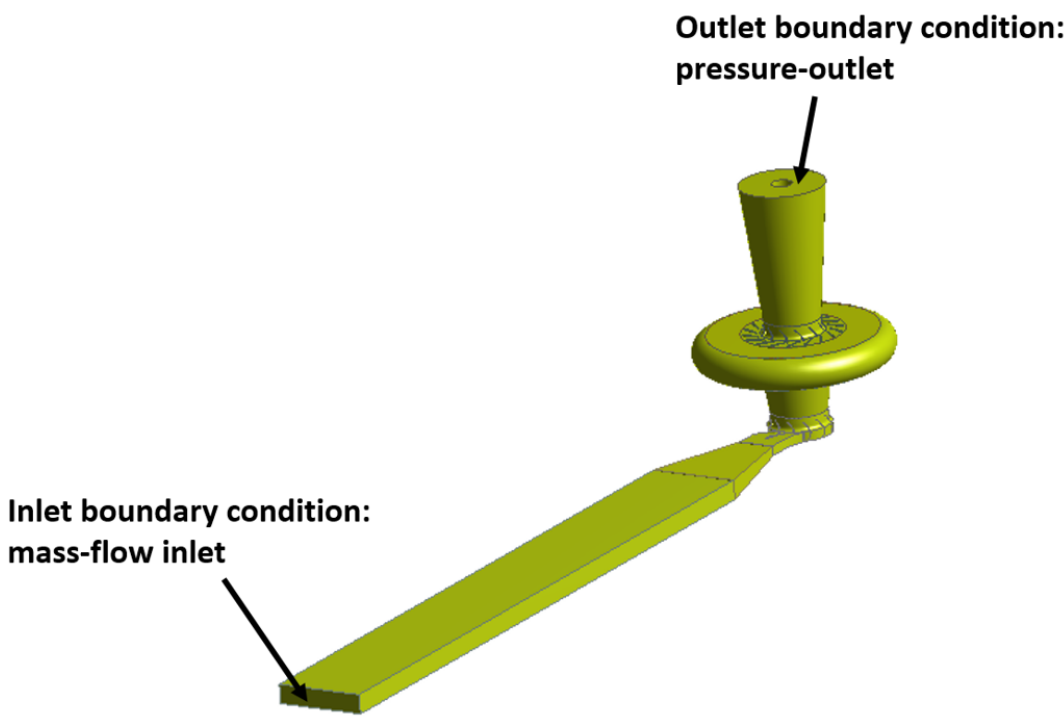
Figure 12. The position of the inlet and outlet boundary conditions [25].